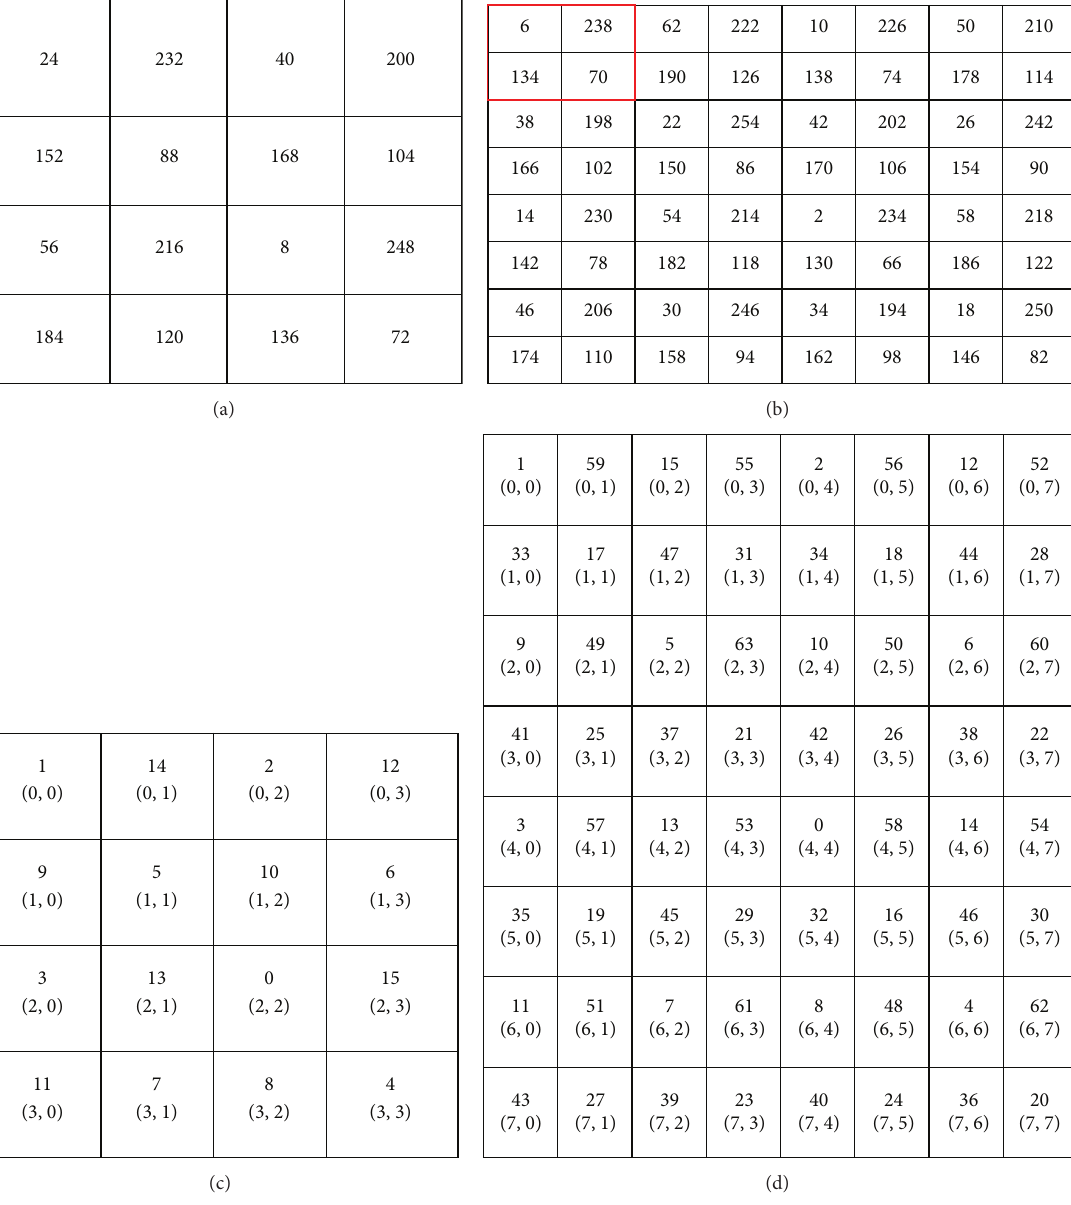
Figure 1: An example of dispersed dithering screens. (a) A 4 × 4 dispersed dithering screen. (b) An 8 × 8 dispersed dithering screen. (c) The order and position of each pixel in (a). (d) The order and position of each pixel in